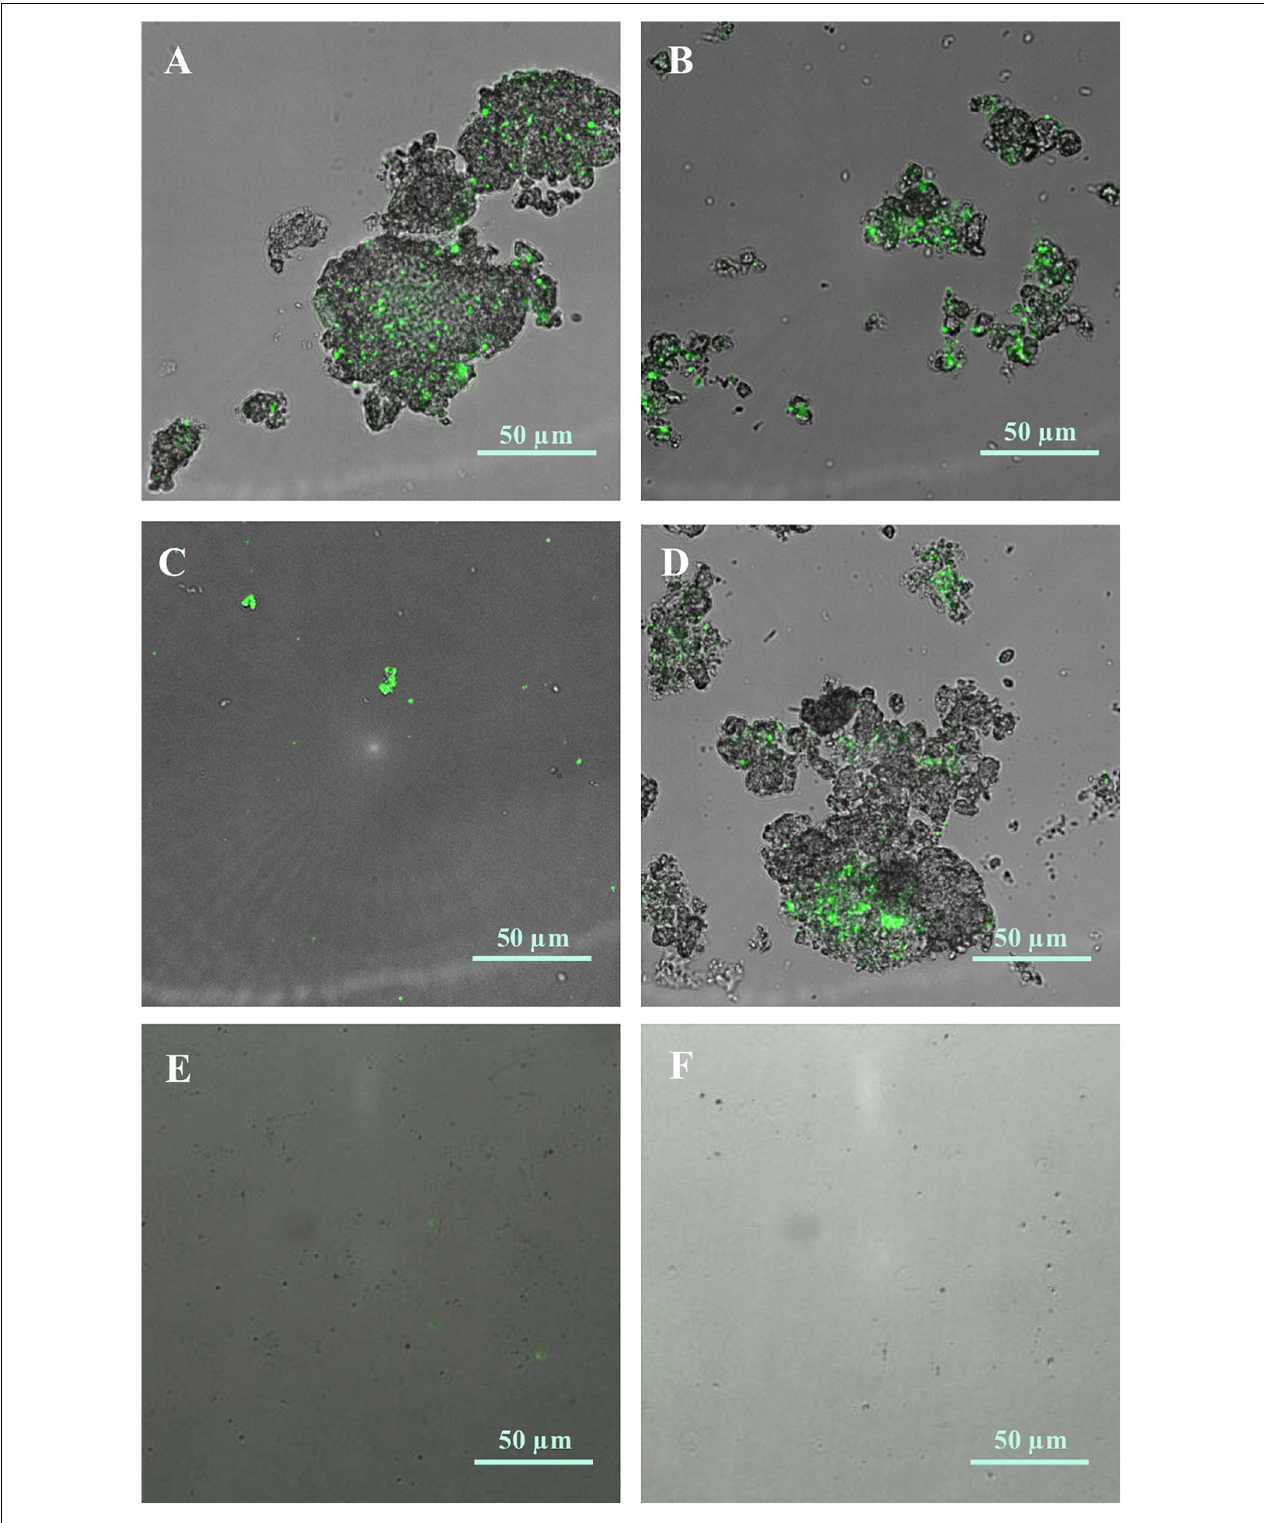
FIGURE 5 | Hetero-aggregation of Prochlorococcus sp. MED4 (green) and nCeO 2 (10 and 100 mg L − 1 ) formed in natural oligotrophic seawater [ (A) ; 10 mg L − 1 and (B) ; 100 mg L − 1 ] and Pro99 media [ (C) ; 10 mg L − 1 and (D) ; 100 mg L − 1 )]. Images were captured using fluorescent microscopy under brightfield and GFP fluorescent and subsequently were merged. No such aggregates were visible in Prochlorococcus culture (E) or natural oligotrophic seawater (F) in the absence of nanoparticles.